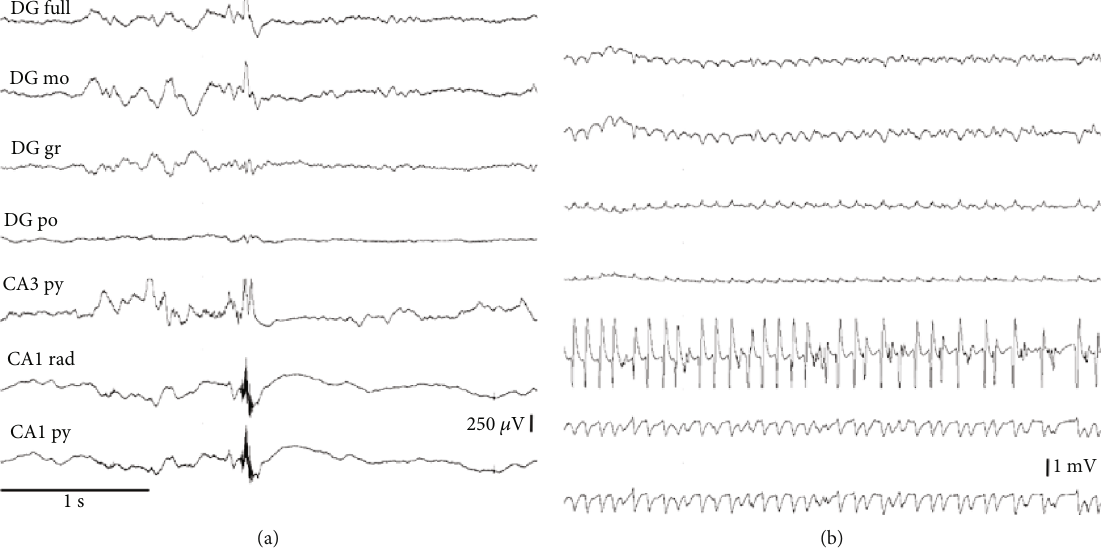
Figure 1: Representative EEG recordings from animals in the epileptic group. (a) Representative FR observed through the microelectrodes placed in the CA1 region. (b) Representative epileptiform activity observed in CA3. The seizure pattern was characterized by spike-wave activity characteristic of seizures of intensity 5 on the Racine scale. Abbreviations: EEG: electroencephalogram; FR: fast ripples; CA: cornu ammonis; mo: molecular cell layer; gr: granule cell layer; po: polymorphic cell layer; py: pyramidal cell layer; rad: radiatum cell